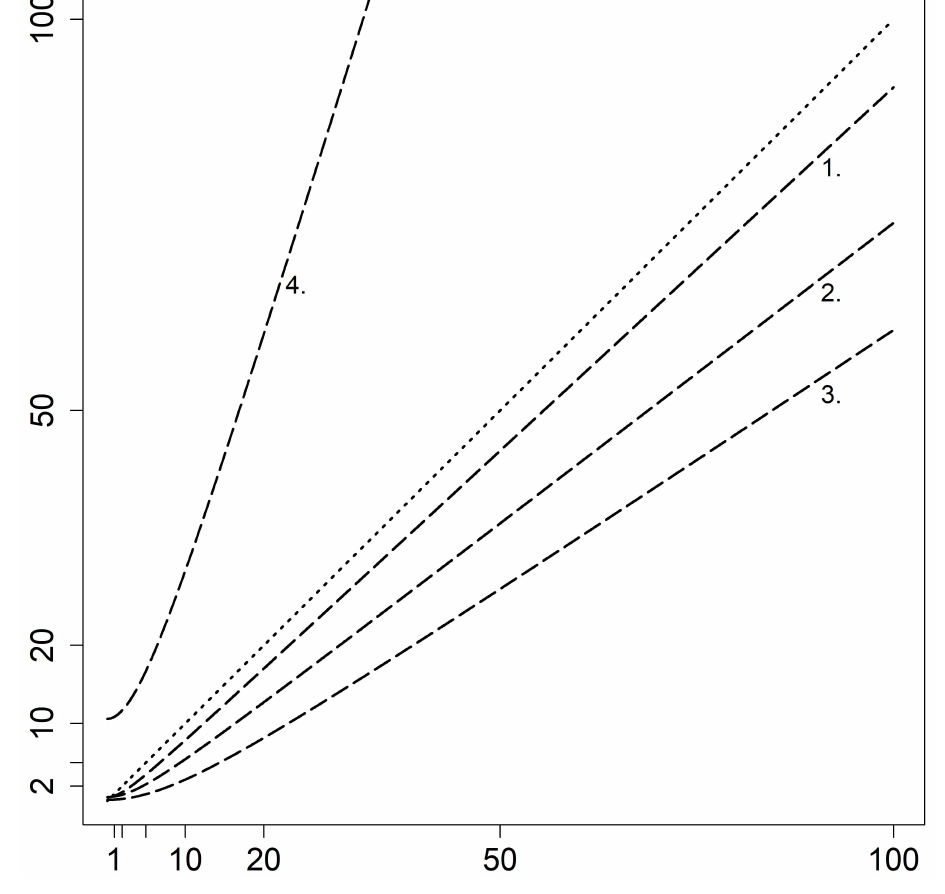
Figure 4. Display of the upper reference limit ( Qlim ) for IgG, IgA, IgM, and FLC-k in relation to the linear function. The steep increase of the Qlim (FLC-k) graph is contrasted by the lower increase of the graph for the Qlim (IgG, IgA, IgM), which results in Qlim –IgG (1.), Qlim –IgA(2.), Qlim –IgM (3.) and Qlim –FLC-k (4.). Qlim –IgG/-IgA/-IgM/-FLC-k = upper limit of the hyperbolic reference